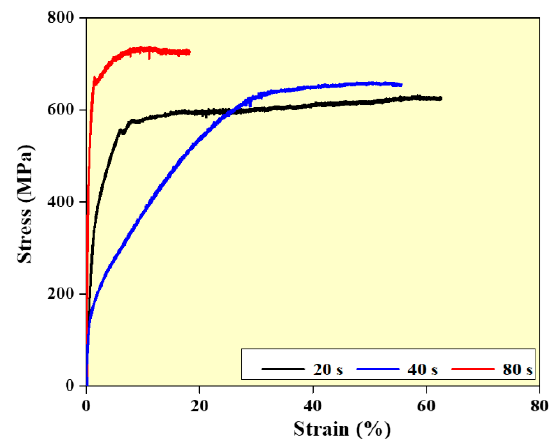
Figure 8. Compression behavior of SS 316L as a function of interlayer delay.